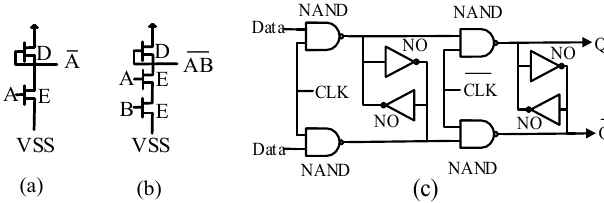
Figure 5. ( a ) NO circuit structure, ( b ) NAND circuit structure, ( c ) D-flipflop circuit structure.